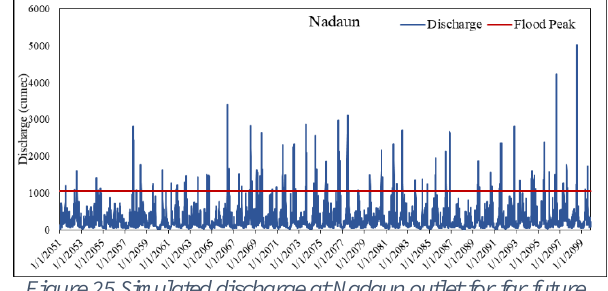
Figure 25 Simulated discharge at Nadaun outlet for far future time period